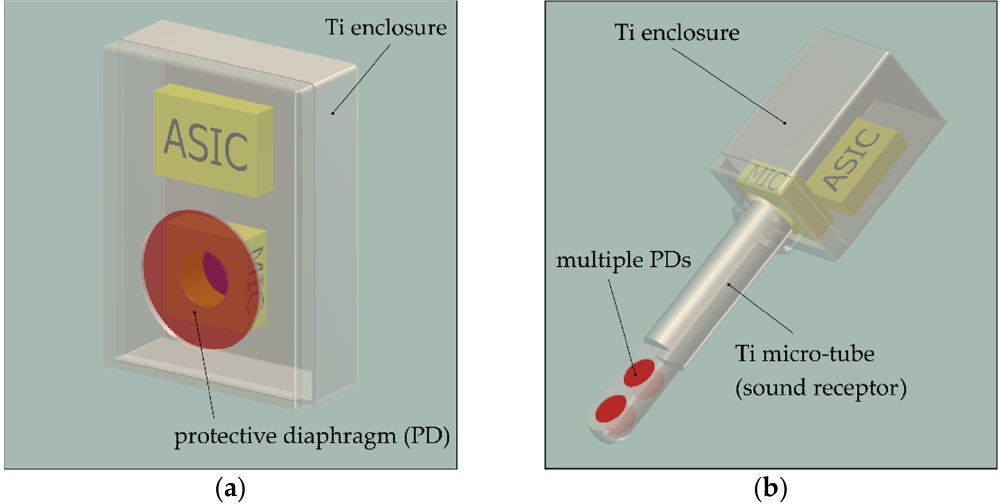
Figure 1. Schematic drawings of a MEMS microphone and the corresponding ASIC packaged in a biocompatible and hermetic Ti enclosure with a PD that can transfer the sound energy to the MEMS transducer. ( a ) A generic enclosure geometry with one larger PD located directly in front of the MEMS microphone diaphragm; ( b ) a more specific enclosure geometry that was developed for an intracochlear acoustic receiver [6] . Four PDs are integrated into a tube-like part of the enclosure to allow the recording of the liquid-borne sound pressure in the human inner ear with sufficiently high receiving sensitivity.